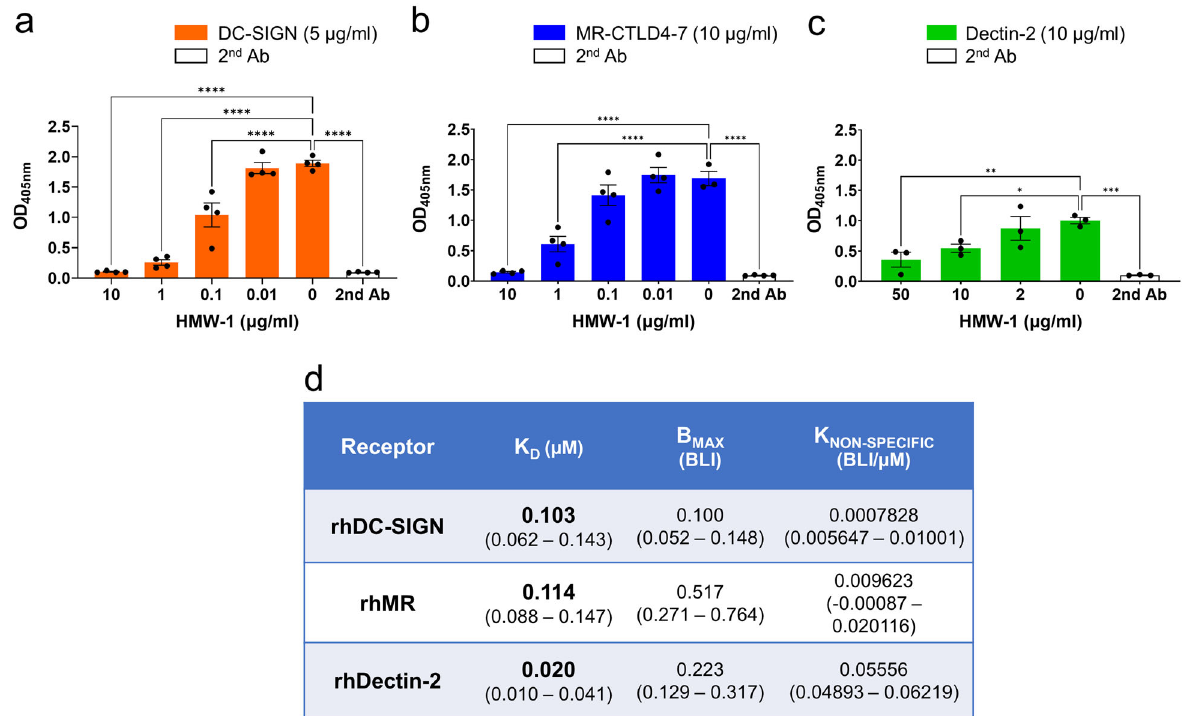
Fig. 3 Binding of DC-SIGN, MR-CTLD4-7 and Dectin-2 to P. aeruginosa bio fi lm carbohydrates. a – c . Lectin competition assays demonstrate dose-dependent inhibition of fucose-PAA (2 µg/ml) binding to DC-SIGN ( a ) and MR-CTLD4-7 ( b ), and of zymosan (1 × 10 6 particles) to Dectin-2 ( c ), by HMW-1. Fc-chimeric proteins and anti-human Fc-secondary antibody conjugated to alkaline phosphatase were used. Graphs show mean ± SEM of 4 independent repeats done in duplicate. Analysis was performed using One-way ANOVA corrected for multiple comparisons using the Dunnett ’ s multiple comparisons test. ****, <0.0001; ***, 0.0007; **, 0.007, *, 0.0493. d HMW-2 bin d s rhDC-SIGN, rhMR, and rhDectin-2. Tetrameric hDC-SIGN, biotinylated and immobilised on a streptavidin sensor and rhMR and rhDectin-2 immobilised on a Ni-sensor were incubated with different HMW-2 concentrations. The table shows equilibrium dissociation constants for the receptor ligand interaction in μ M (K D ); receptor density on the biosensor surface (B MAX ) and nonspeci fi c binding (K NON-SPECIFIC ). 95% con fi dence intervals in µM are shown within